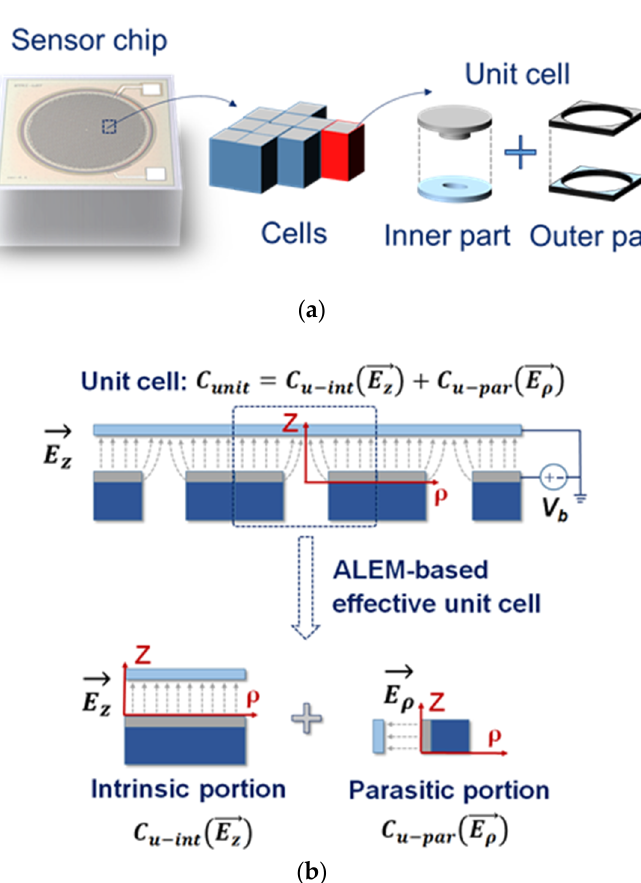
Figure 3 . ( a ) Diagram of a capacitive MEMS acoustic sensor composed of unit cells; ( b )